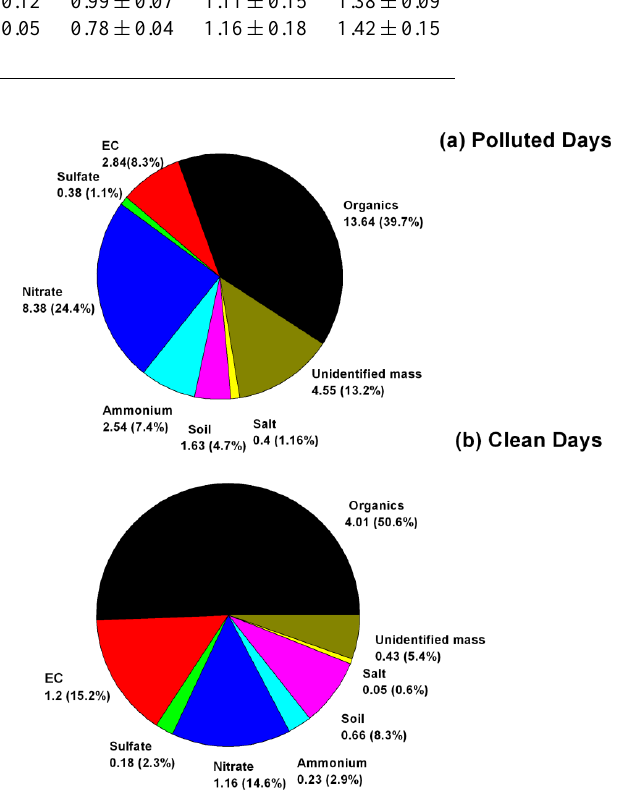
Fig. 5. Twenty-four-hour average PM 2 . 5 component concentrations (µgm − 3 ) for (a) polluted days (18 and 24 December and 5 January) and (b) clean days (21 December and 14 and 17